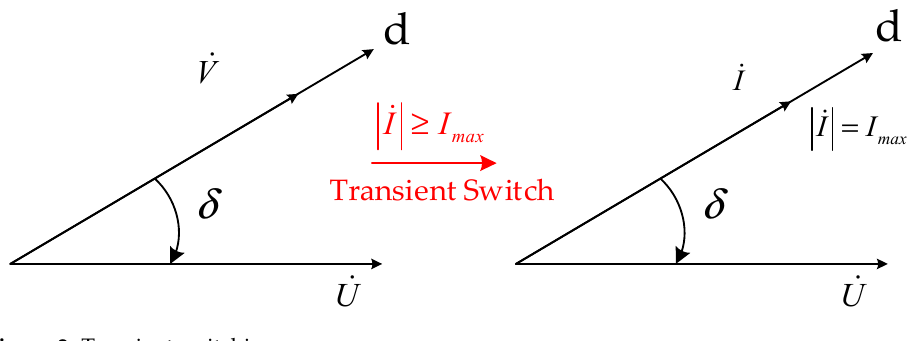
Figure 2. Transient switching process.